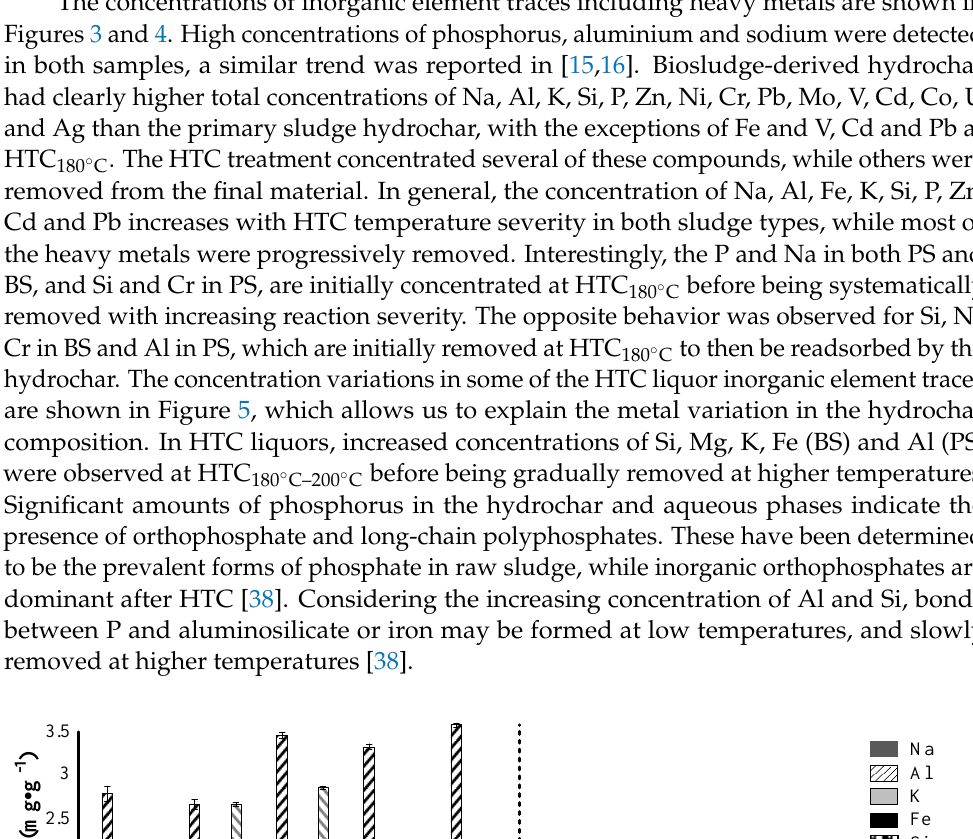
Figure 4. Heavy metals in feedstock and hydrochar BS and SP samples. Figure 5. Inorganic elements in feedstock-liquor and HTC-liquor of BS and SP samples.